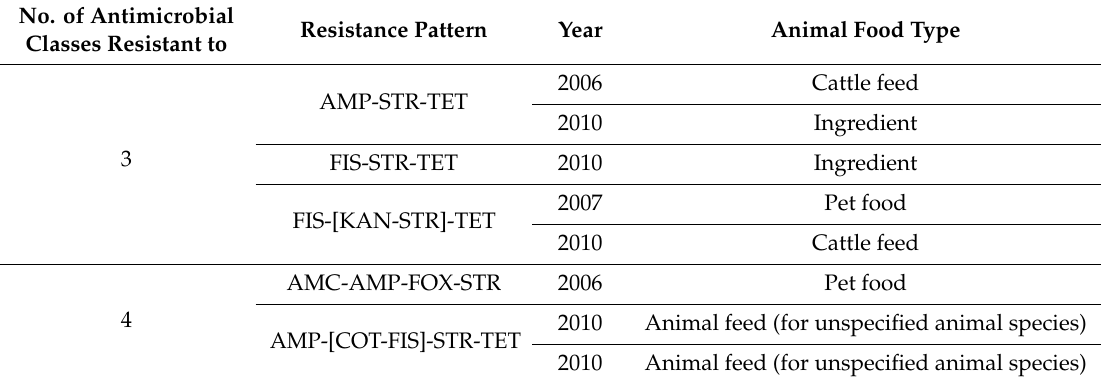
Table 4. Multidrug-resistant E. coli isolates (resistant to ≥ 3 antimicrobial classes).